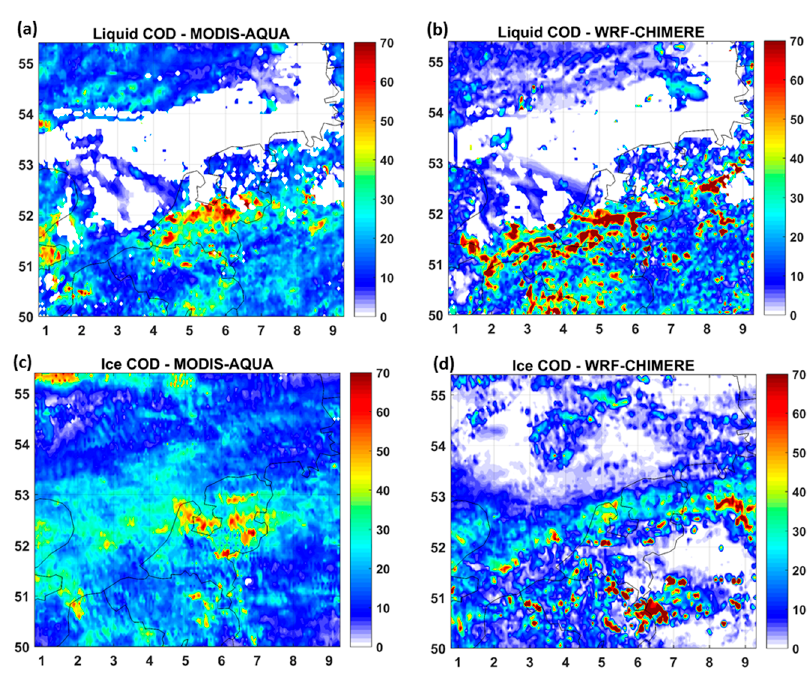
Figure 10. Panel ( a , b ) show the trimeans of liquid cloud optical depth retrieved by MODIS-Aqua and the one predicted by WRF-CHIMERE. Panel ( c , d ) display the observed and simulated ice cloud optical depth.